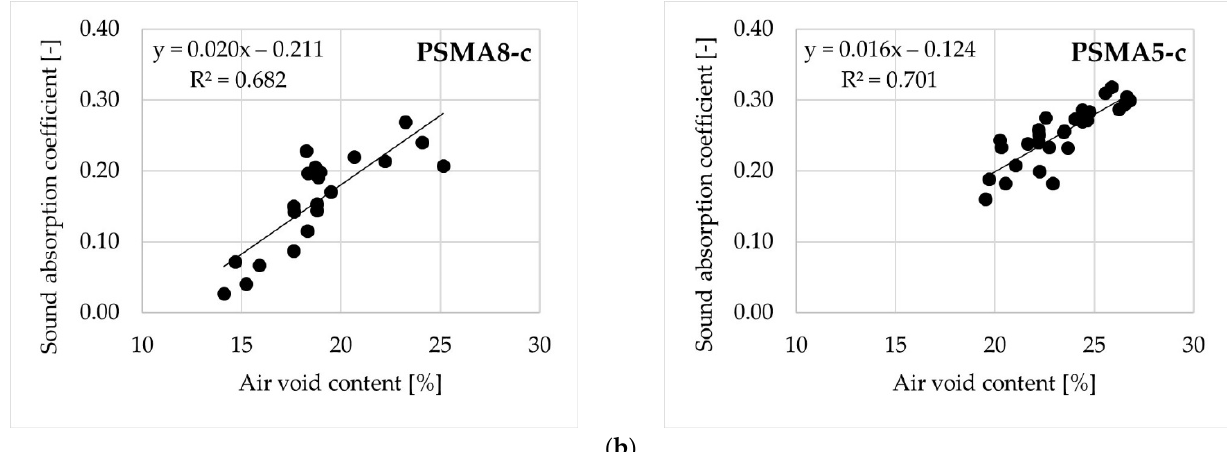
Figure 12. The influence of air voids on sound absorption coefficient: test slabs ( a ) and cylindrical specimens ( b ).